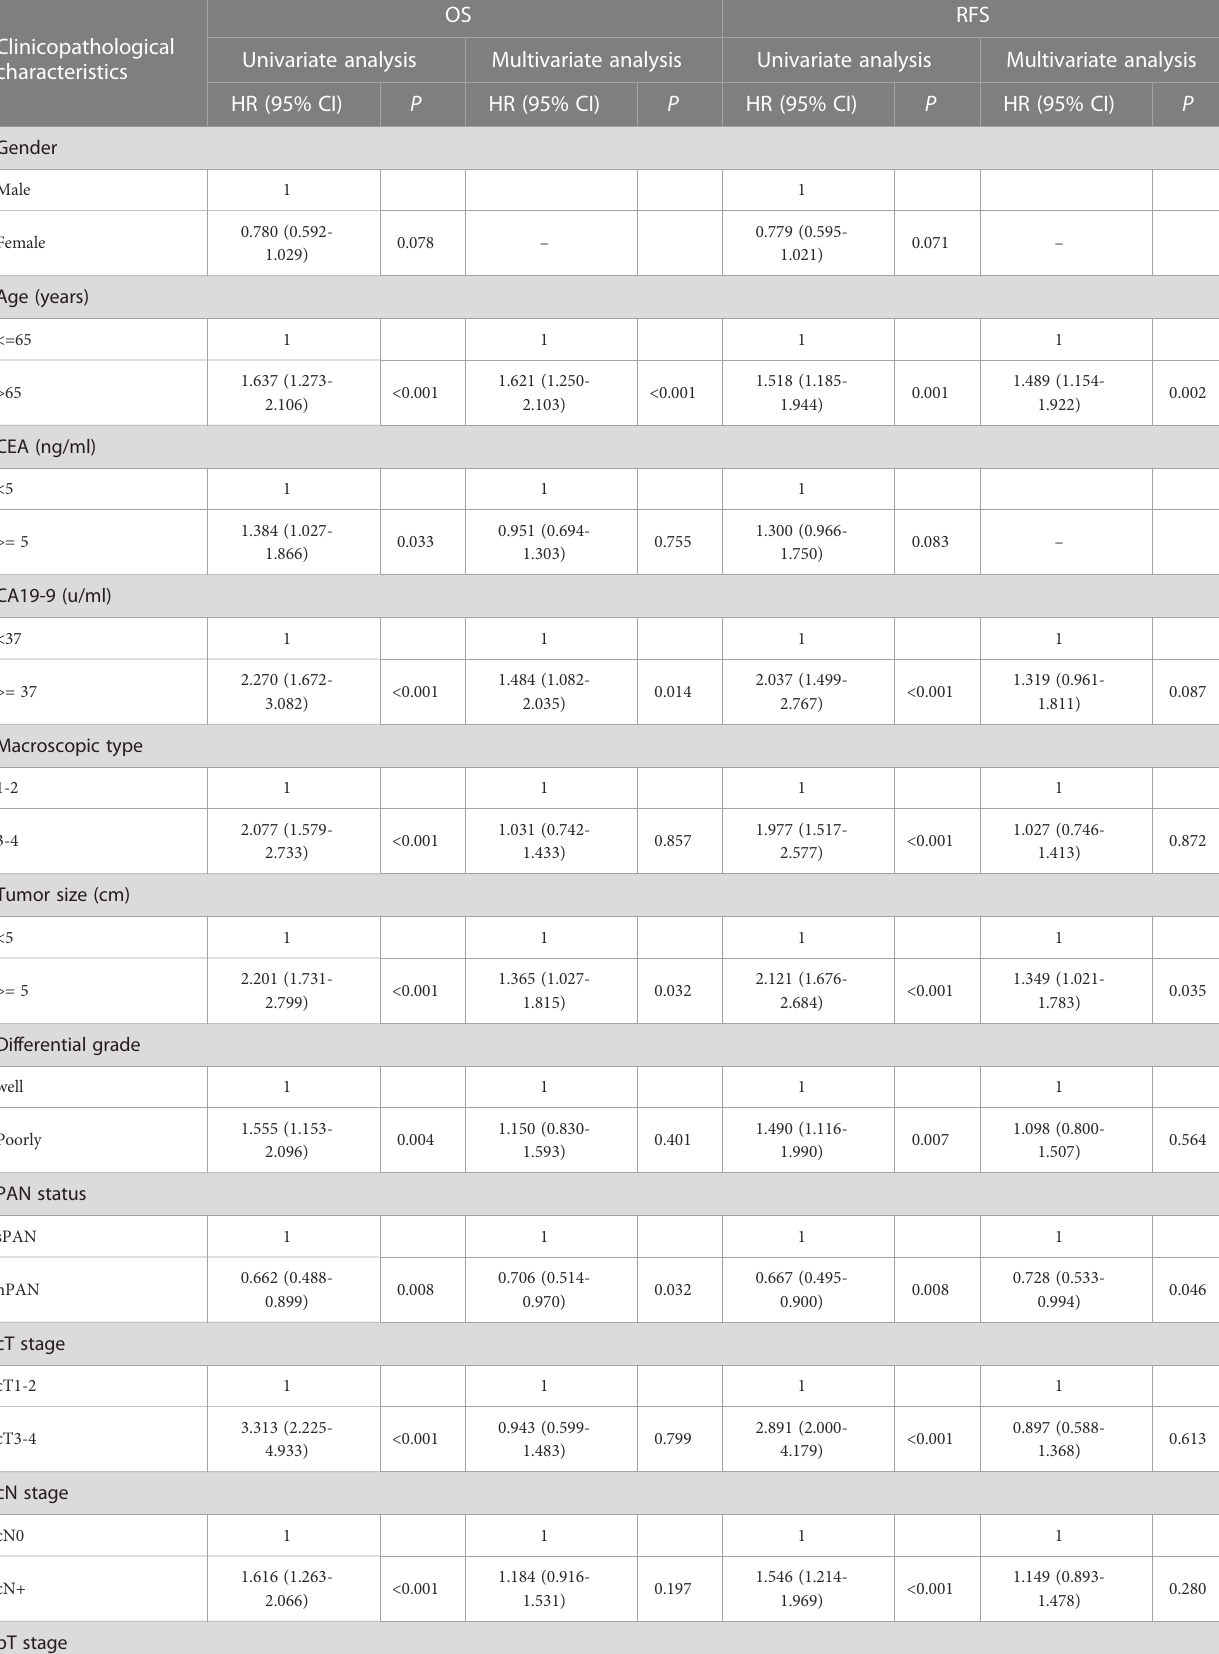
TABLE 3 Univariate and multivariate analysis of risk factors for OS and RFS of overall gastric cancer